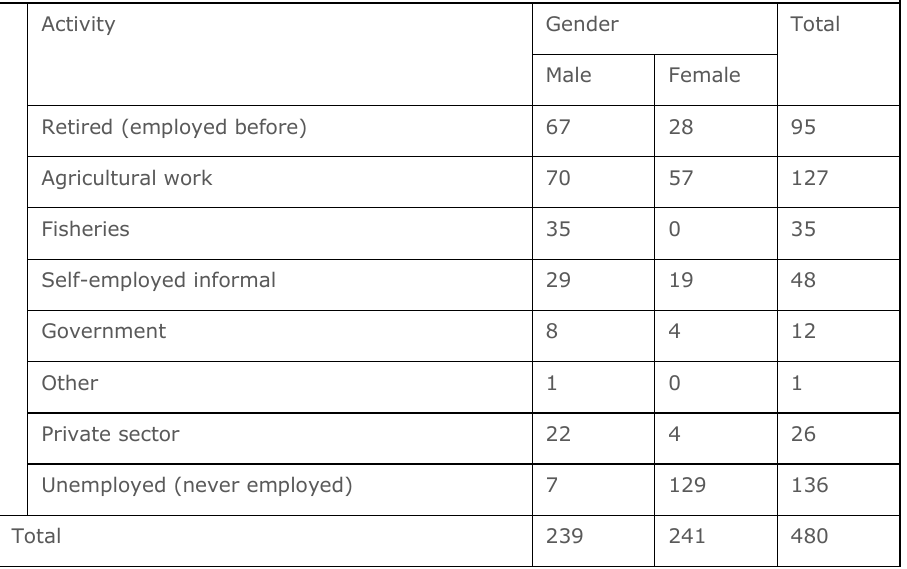
Table 6: Current income earning activity of elderly persons by gender Activity Gender Total